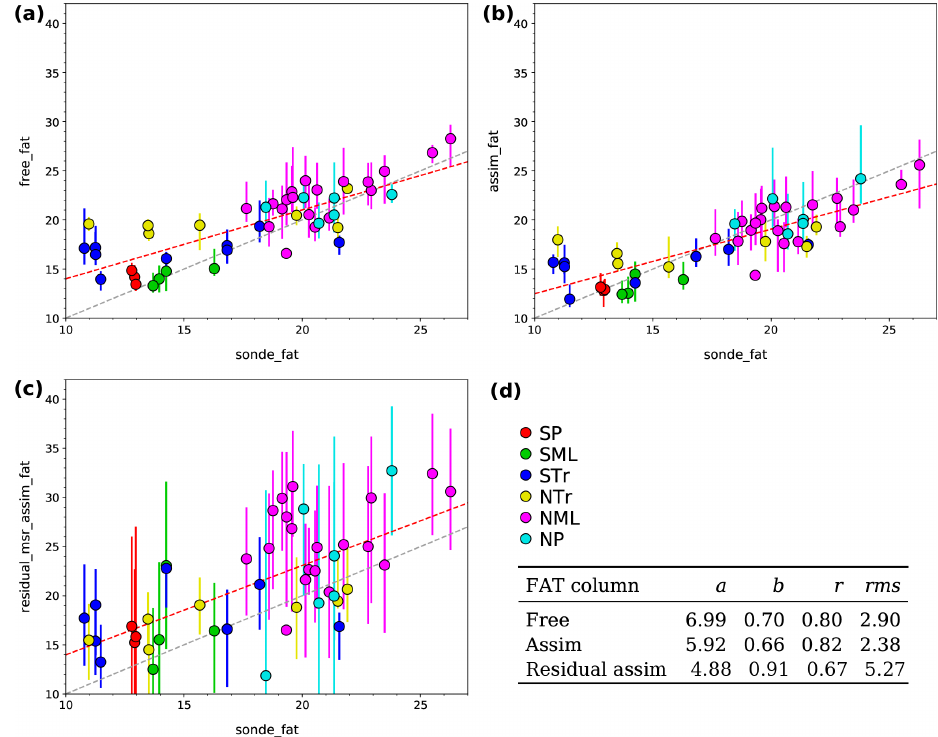
Figure 5. Scatterplots of tropospheric columns based on model output versus sonde measurements. The plot symbols are the median values of collocations grouped by station. The error bars indicate the 25th–75th percentiles of the distribution. Panel (a) : free model run; (b) : assimilated O 3 fields; (c) : residual-FAT column for the assimilated O 3 fields. Colours indicate 30 ◦ latitude bands: SP – South Pole; SML – southern midlatitudes; STr – southern tropics; NTr – northern tropics; NML – northern midlatitudes; NP – North Pole. The grey dashed line is the 1 : 1 line, and the red dashed line gives the best linear fit to the data. The fit parameters are listed in the table at (d) . The columns marked a and b are the linear fit parameters of the line a + bx ; r is the linear Pearson correlation coefficient; rms is the root mean square between the values on both axes. The number of stations included in each plot is